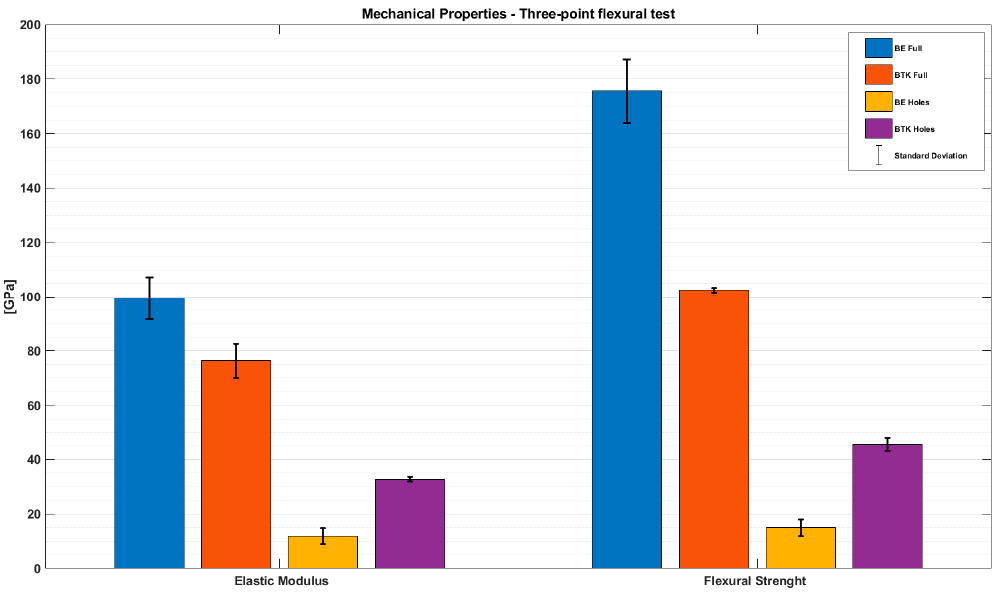
Figure 3. Graphical representation of elastic modulus and flexural strength values on the four types of specimens. The analysis with an optical microscope at different pH at 7, 14, and 21 days, respec- tively, did not reveal any macroscopic alteration of the surface (Figure 4).